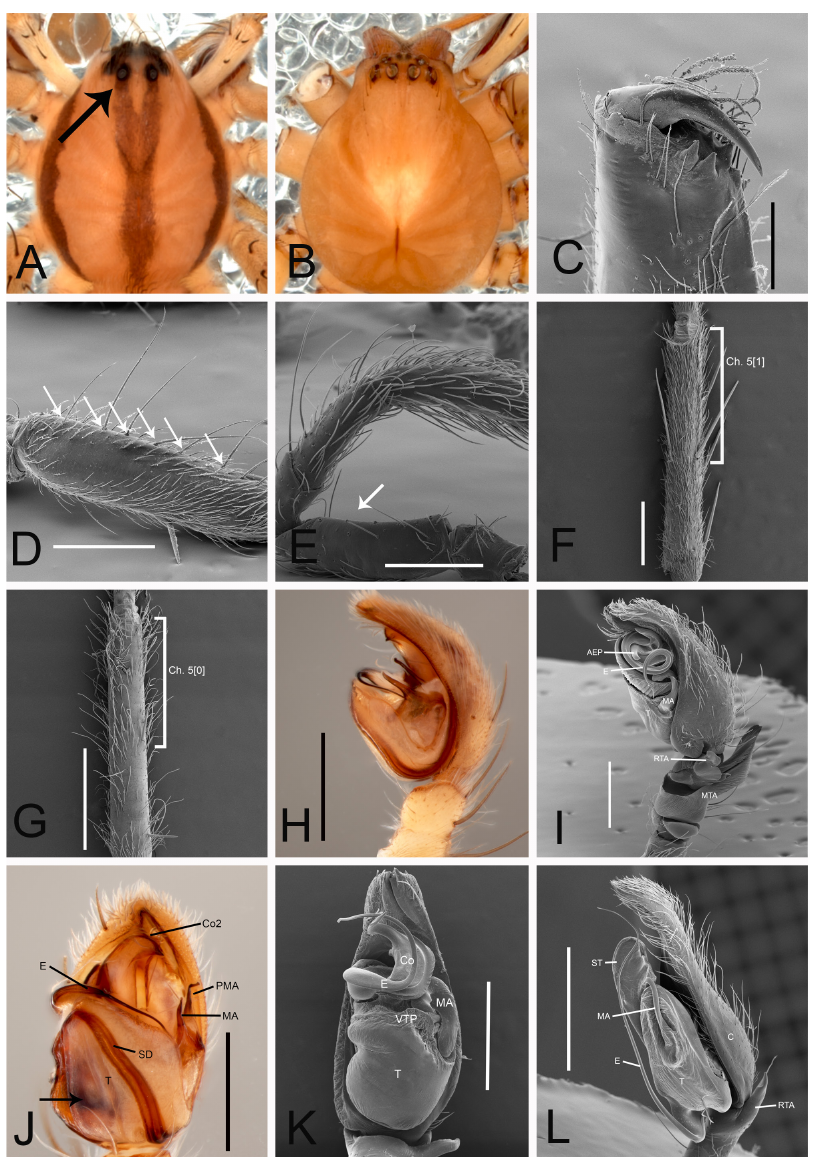
Fig. 6. A . Arachosia praesignis (Keyserling, 1891), ♂, cephalothorax, dorsal view (arrow shows row of the eyes) (IBSP 87975). B . Patrera fulvastra Simon, 1903, ♂, cephalothorax, dorsal view (MCN 24207). C . Arachosia praesignis , ♂, chelicera, ventral view (IBSP 87975). D . Aysha prospera Keyserling, 1891, ♀, palp femur, prolateral view (arrows show setal row) (IBSP 19780). E . Tafana silhavyi (Caporiacco, 1955), ♀, prolateral view (arrow indicating the absence of setae) (MNHN 11312). F . Arachosia praesignis , ♂, leg I, tibia, ventral view, scopulae (IBSP 87975). G . Tafana riveti Simon, 1903, ♂, leg I, tibia, ventral view, scopulae (MCZ). H . Arachosia praesignis , ♂, palp, retrolateral view (IBSP 87975). I . Aysha prospera , ♂, palp, retrolateral view (IBSP 38914). J . Arachosia praesignis , ♂, palp, ventral view (arrow shows the basal notch on the tegulum) (IBSP 87975). K . Xiruana gracilipes (Keyserling, 1891), ♂, palp, ventral view (IBSP 72660). L . Patrera fulvastra , ♂, palp, retrolateral view (MCN 24207). Abbreviations: AEP = apophysis of embolic process; C = cymbium; Co = conductor; Co2 = secondary conductor; E = embolus; MA = median apophysis; MTA = median tibial apophysis; PMA = paramedian apophysis; RTA = retrolateral tibial apophysis; SD = sperm duct; ST = subtegulum; T = tegulum; VTP = ventral tegular process. Scale bars: C = 0.2 mm; D, K = 0.4 mm; E = 0.3 mm; F, H–J = 0.5 mm; G, L = 1